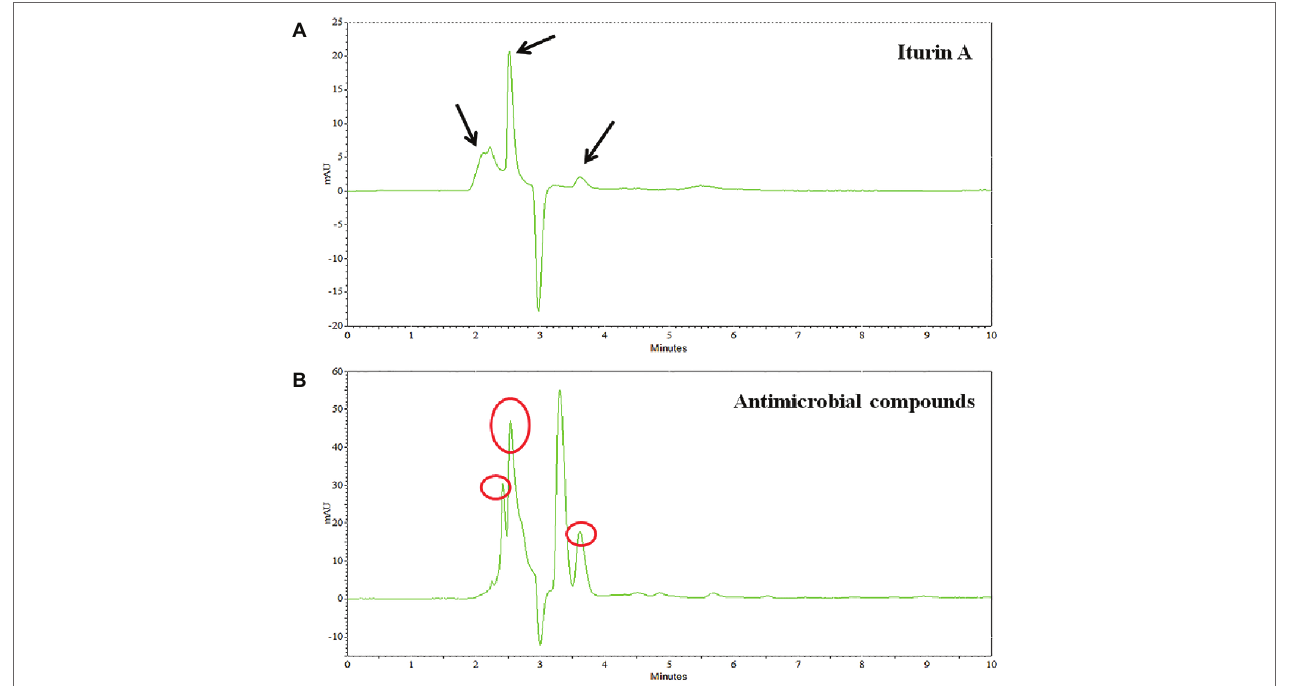
FIGURE 7 | HPLC preliminary identification of iturin A (A) and crude extracts of SL-44 (B)